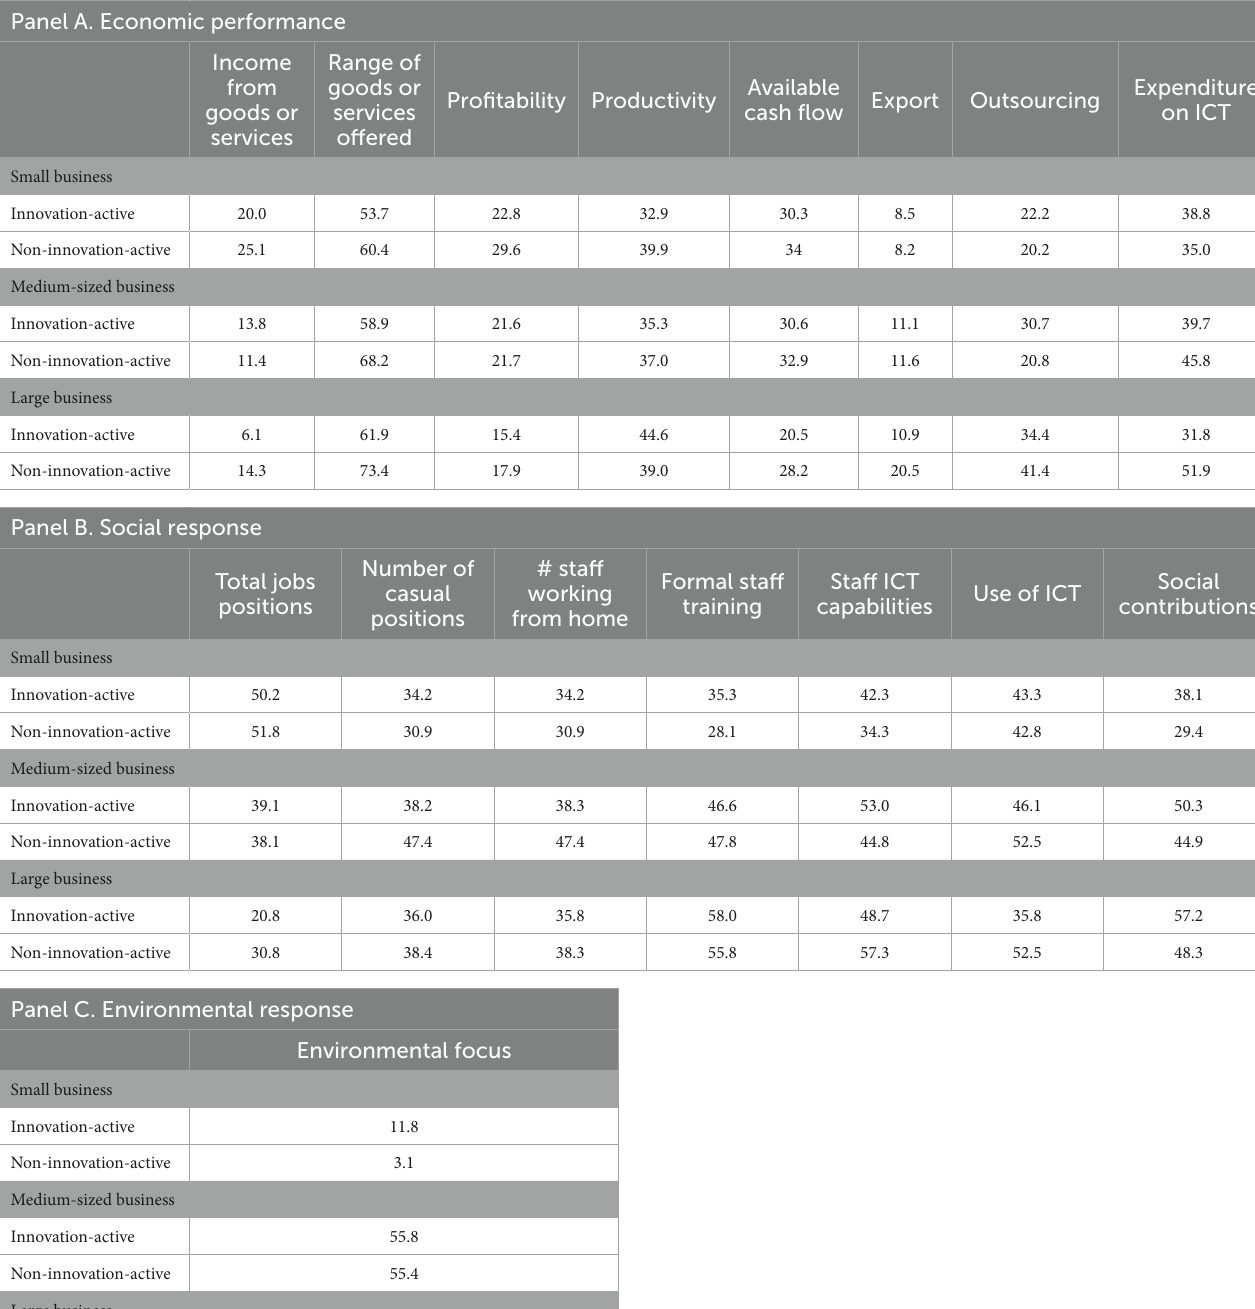
Income Range of from goods goods or services